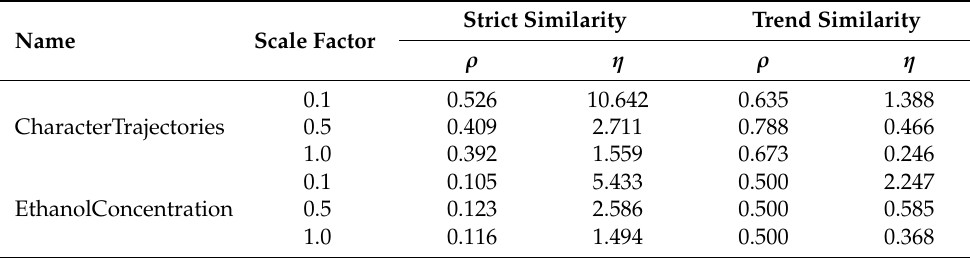
Table 4. Scalability on datasets with different lengths of time